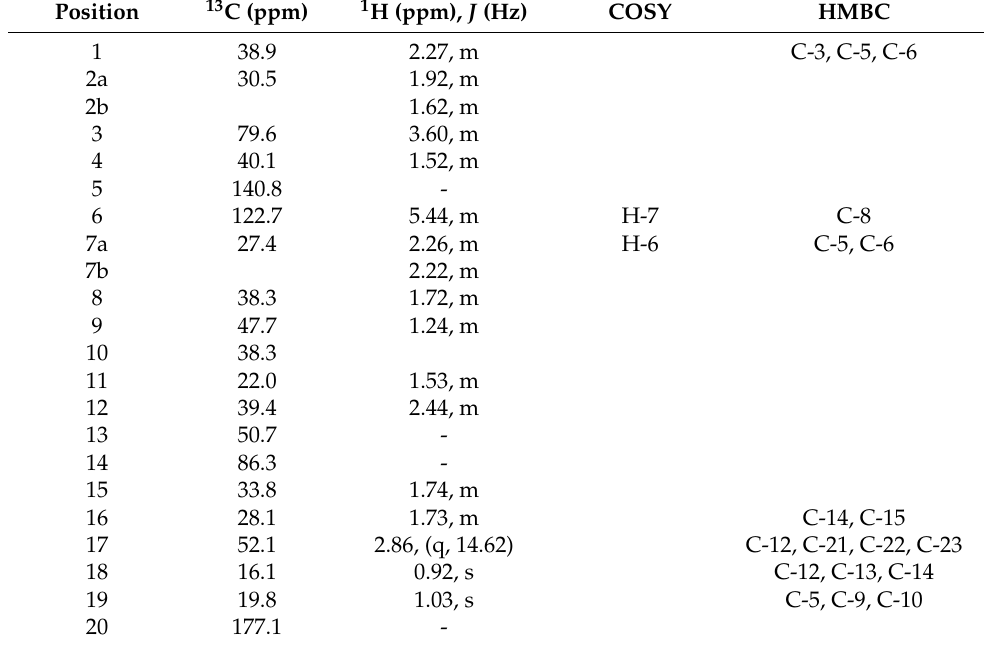
Table 2. 1 H NMR and 13 C NMR data for xysmalogenin-3, β - D -glucopyranoside ( 2 ) in MeOD- d4